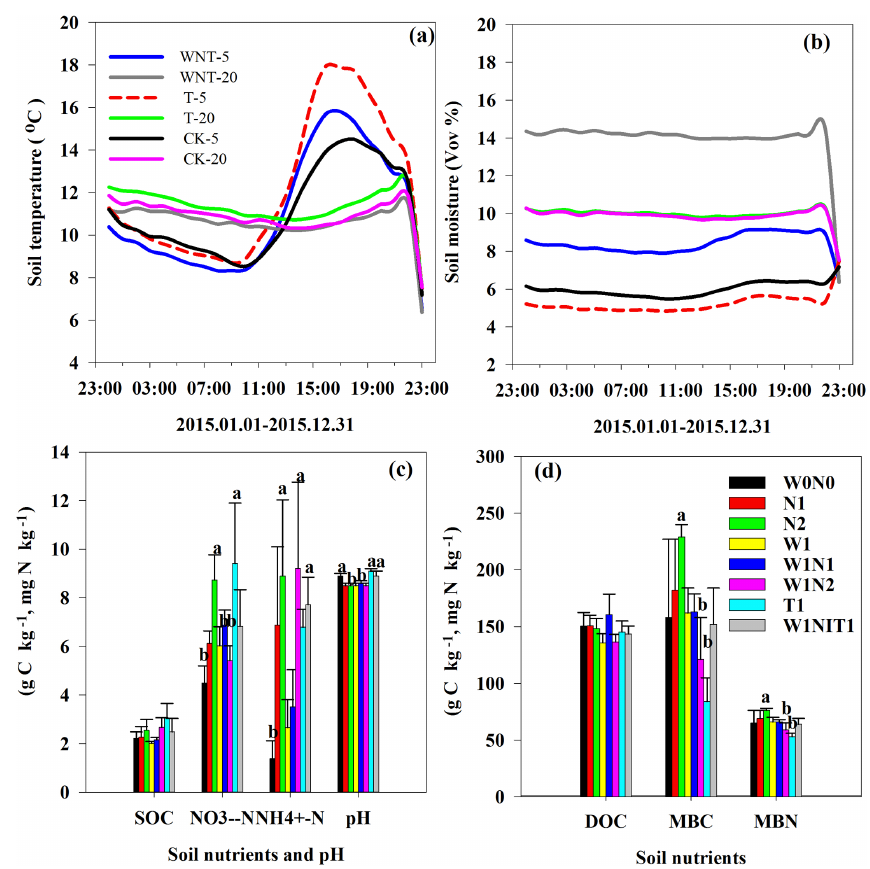
Figure 1. Comparative effects of warming from open-top chambers (OTCs), increased precipitation and N deposition on soil temperature (a) , soil moisture (b) at 5 and 20cm depth; soil organic carbon (SOC), NH + (DOC), microbial biomass carbon (MBC) and microbial biomass nitrogen (MBN, d ). The data are mean ± SE, n = 4 in (c) and (d) ; different letters indicate significant effect at P